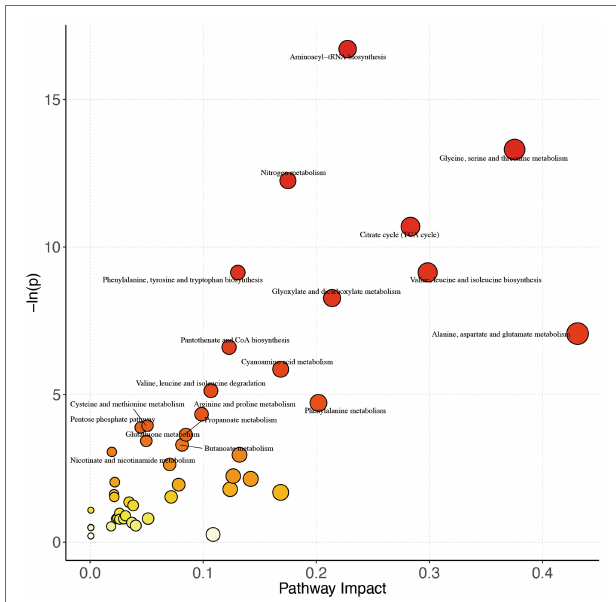
FIGURE 2 | Pathway analysis bubble plot by the HSA set in KEGG. On the horizontal axis is the pathway impact, which represents the importance of differential metabolites in metabolic pathways. The vertical axis is the negative logarithm of p value obtained from pathway enrichment analysis. The size of pathway symbols represents the statistical significance level of pathway analysis. The color of pathway symbols represents the impact factor; large sizes and dark colors represent central pathway enrichment and high pathway impact values,